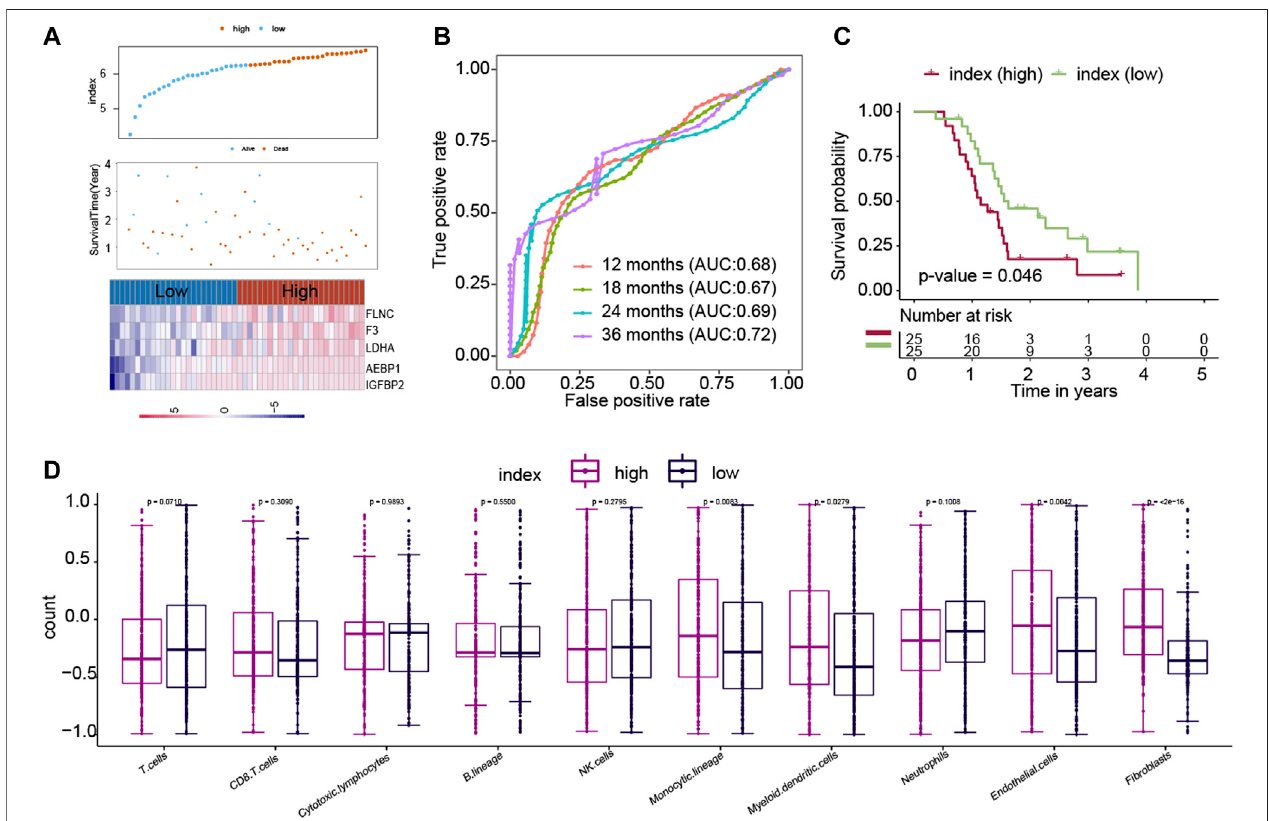
FIGURE 4 | EvaluationoftheECMindexintheindependentdataset(GSE83300).TheECMindexofallpatientsintheGSE83300dataset (A – C) wascalculatedbythe same formula and was divided intoa high- and a low-index group. (D) Comparison ofimmune cells and stromal cells between thanthe low – and high – ECM index patients.